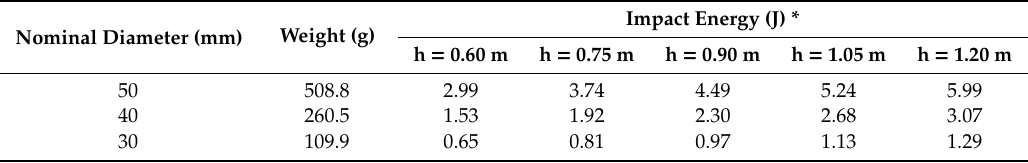
Table 2. Steel ball characteristics and impact